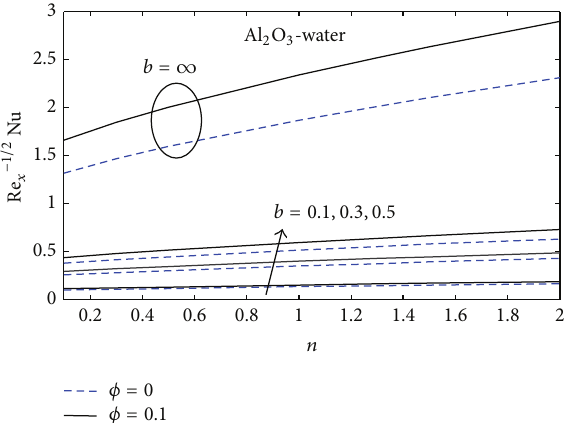
Figure 8: Pr = 6.2 , 𝑀 = 0.5 , 𝐴 = 0.5 , and 𝑓 𝑤 = 0.1 .